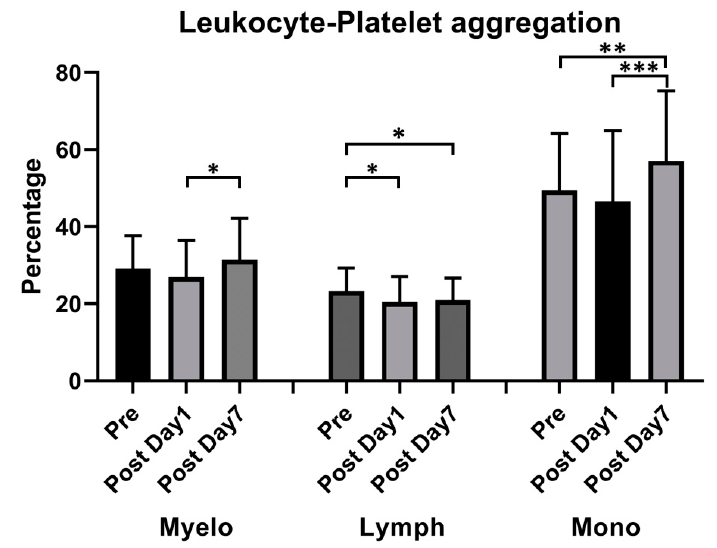
Figure 3. Effect of ChAdOx1 nCoV-19 vaccination on platelet-promoted leukocyte aggregation. Quantitative analysis of platelet–leukocyte aggregates: Myeloid (Myelo), Lymphocyte (Lymph), and Monocyte (mono). * p < 0.05; ** p < 0.01, *** p < 0.001.